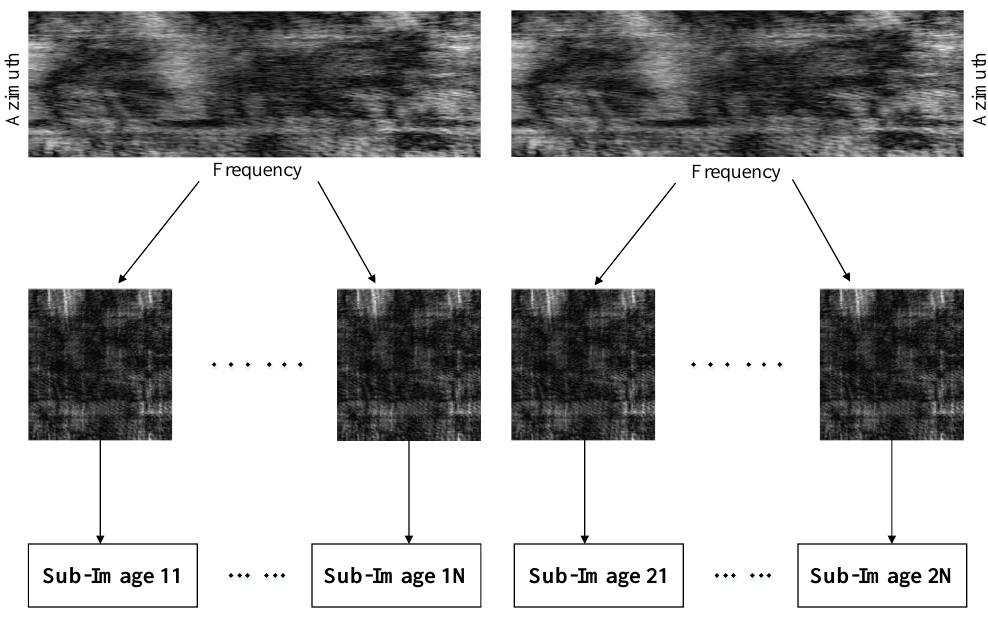
Figure 2. Generation process of frequency interleaved sub-images.